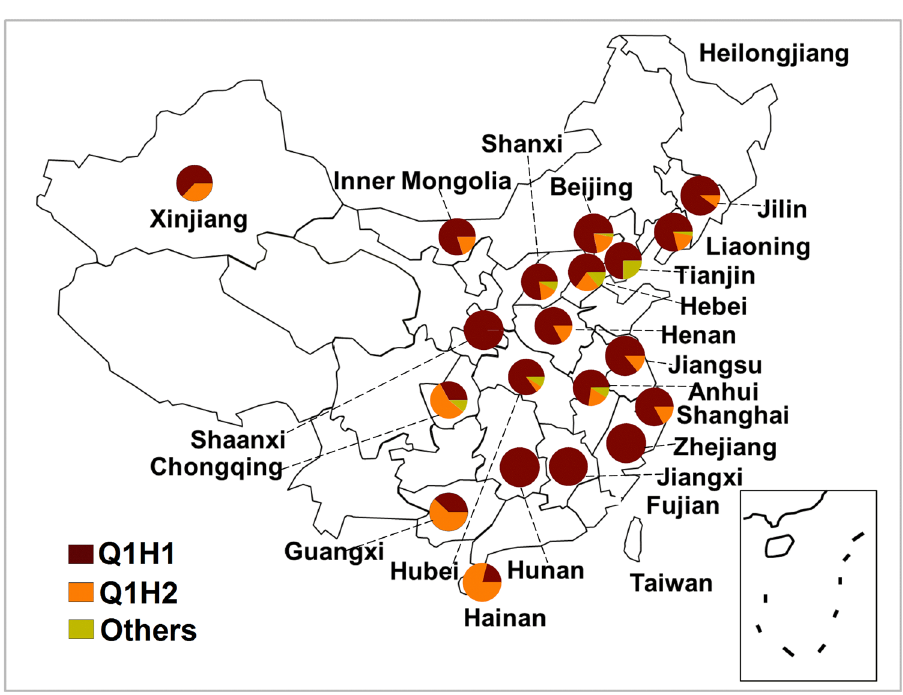
Figure 2. Distribution of haplotypes among Bemisia tabaci Q in China in 2011 based on 773-bp mtCOI fragment. Circles denote proportion of Q1H1 (brown), Q1H2 (yellow) and other haplotypes (light green) in collections. This China map was created using Microsoft PowerPoint (version 2010) by author Hui-Peng